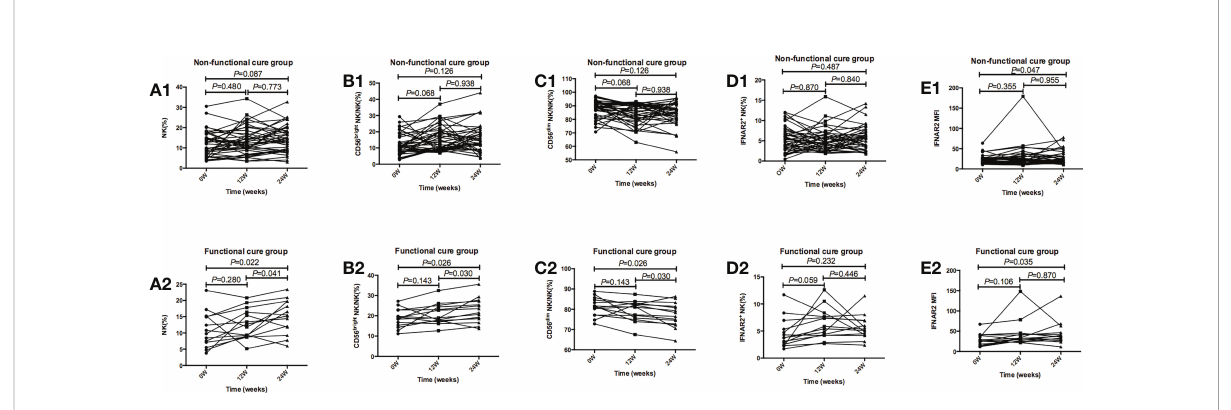
FIGURE 3 Tendencies of NK cells frequency and function, including NK%, CD56bright NK/NK%, CD56dim NK/NK%, IFNAR2+ NK/NK%, and IFNAR2 MFI at baseline and after 12 and 24 weeks of treatment in the Functional cure group and Non-functional-cure group. (A1-E1) Tendencies of NK% (A1) , CD56bright NK/NK% (B1) , CD56dim NK/NK% (C1) , IFNAR2+ NK/NK% (D1) , and IFNAR2 MFI (E1) at baseline and after 12 and 24 weeks of treatment in the Non-functional-cure group. (A2-E2) Tendencies of NK%(A2), CD56bright NK/NK% (B2) , CD56dim NK/NK% (C2) , IFNAR2+ NK/ NK% (D2) , and IFNAR2 MFI (E2) at baseline and after 12 and 24 weeks of treatment in the Functional cure group. p values for multiplicity were ajusted by Bonferroni, and P < 0.016 was denti fifi ed as signi fifi cant statistical